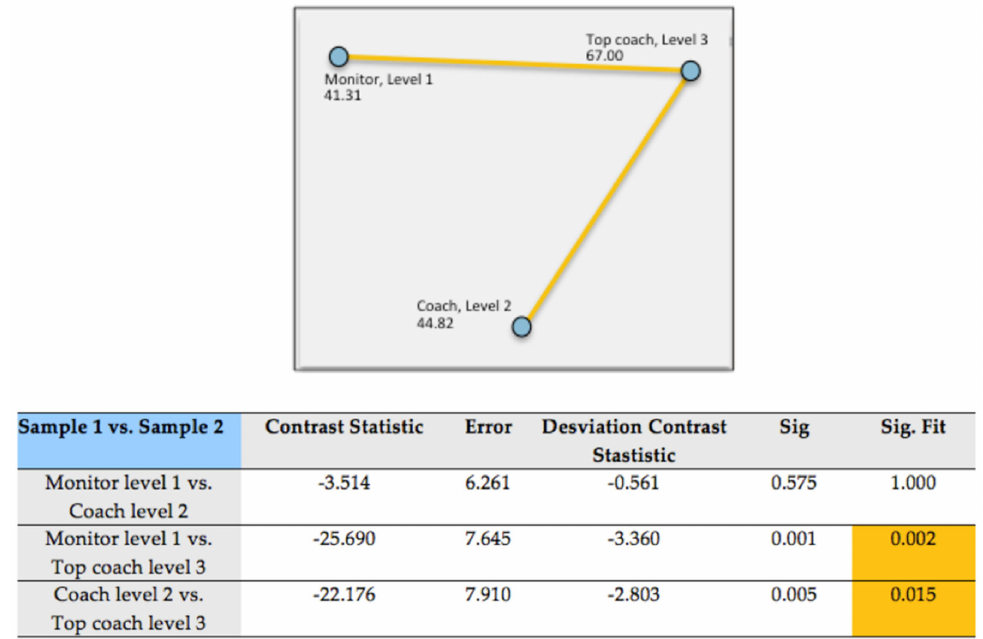
Figure A8. Active work and development possibilities according to the basketball qualification.